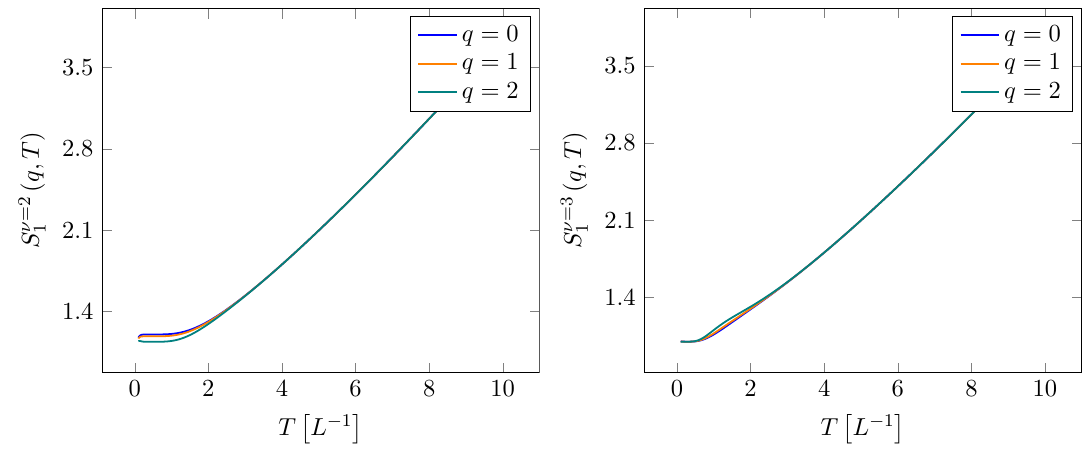
Figure 3 . Temperature dependence, in unit of the inverse spacial dimension of the system, for the entanglement entropy of a subsystem composed of an interval of length 0 . 4 L in the ν = 2 (left) and ν = 3 (right) spin sectors, obtained from eq. (3.32), with the constant (cid:15) evaluated for N = 300 in eq. (3.28). The asymptotic linear growth for higher temperatures reproduces the well known thermodynamic entropy of free fermions (quantum correlations are subleading at higher